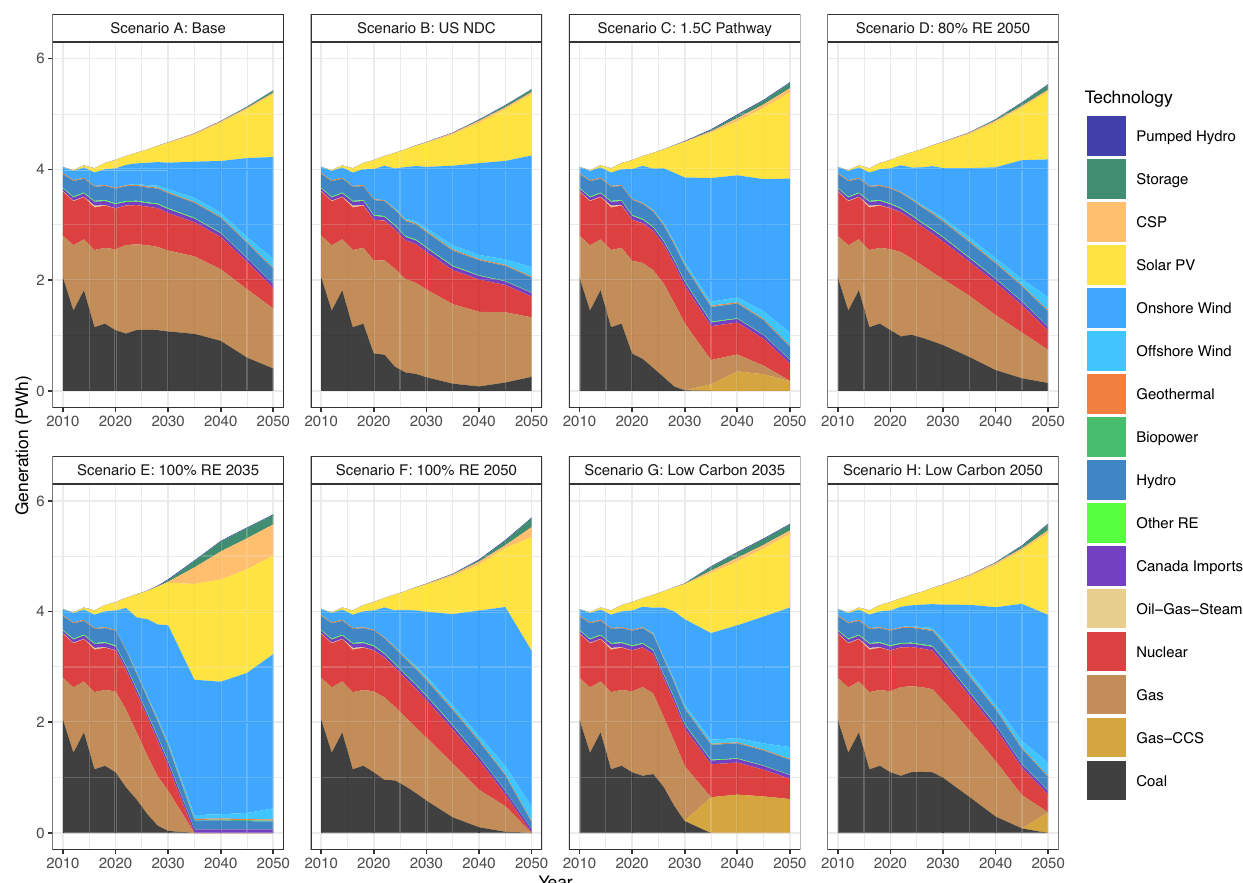
Fig. 1 | Annual generation mix (PWh) 2010 – 2050 by technology for each dec- arbonization scenario resulting from the ReEDS model. We highlight that the renewable and low carbon technology mandates accommodate additional energy